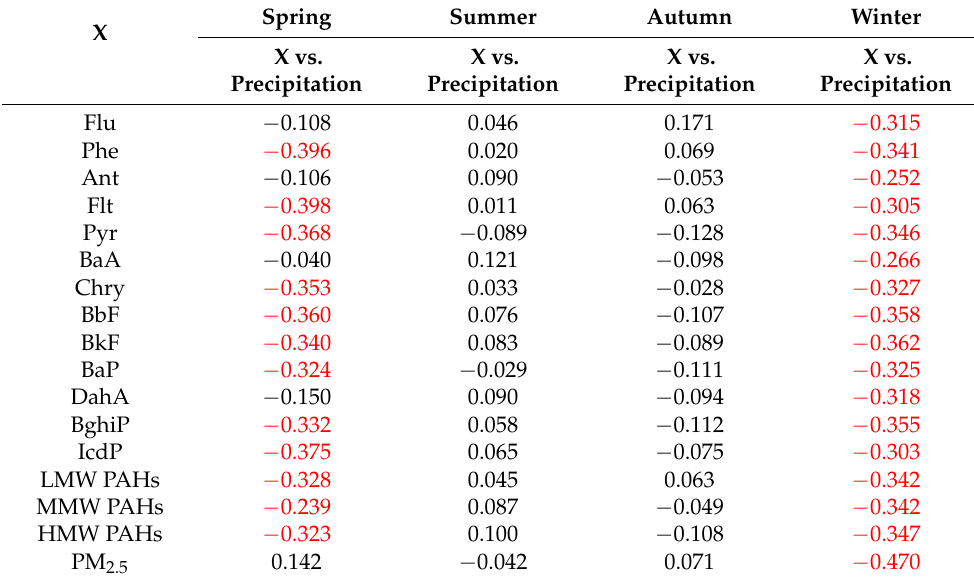
Table 1. Spearman’s rank correlation coefficients between precipitation and chemical variables (X: PM 2.5 mass concentration/PAH concentrations). Statistically significant ( p < 0.05) correlations are marked in red. Spring Summer Autumn Winter X X vs. X vs. X vs. X vs. Precipitation Precipitation Precipitation Precipitation Flu − 0.108 −